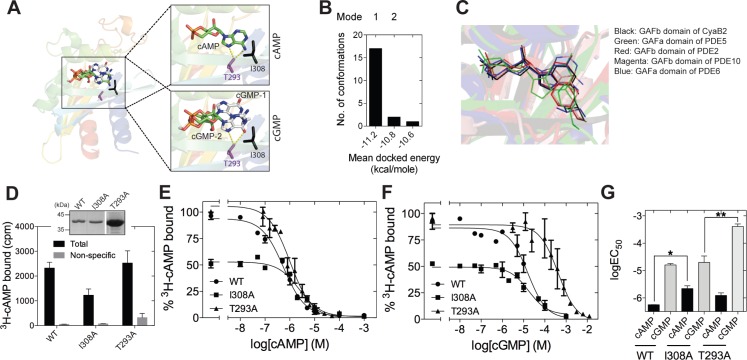
Ligand binding to the isolated GAFb domain of CyaB2.(A) Cartoon representation of the GAFb domain (PDB: 1YKD Martinez et al., 2005) with docked cAMP and cGMP conformers. Insets show zoomed in view of the ligand binding pocket of GAFb with docked cAMP and two different clusters of docked cGMP conformers indicated as cGMP-1 and cGMP-2. Side chains of T293 and I308 are also shown along with their interaction with the docked ligands. (B) Distribution of docked cGMP conformers obtained clustering with an RMSD of 0.5 Å. Mode 1 represents the cluster with maximum number of conformers and with lowest energy while mode 2 represents the cluster with cGMP docked in a way that mimics bound cAMP. Third cluster consisting of one conformer out of 20 was docked outside the ligand-binding pocket and therefore, has not been shown. (C) Conserved interaction between high affinity ligand, either cAMP or cGMP, with the residue equivalent to I308 in different cyclic nucleotide binding GAF domains (GAFb domain of CyaB2–cAMP [PDB: 1YKD]; GAFb domain of PDE2–cGMP [PDB: 1MCO]; GAFa domain of PDE5–cGMP [PDB: 2K31]; GAFb domain of PDE10–cAMP [PDB: 2E4S]; GAFa domain of PDE6–cGMP [PDB: 3DBA]. (D) Wild type (WT), I308A or T293A mutant GST-fusion proteins (∼1–5 µg) bound to glutathione beads were incubated with 3H-cAMP (∼1 nM) in the absence or presence of 10 µM unlabeled cAMP. Data shown is a representative of assays performed at least twice in duplicate, and values shown are mean ± S. E. M. for 1 µg protein. The inset shows a Coomassie stained gel picture of the purified proteins used in the assay. (E) and (F) Purified wild type, I308A or T293A mutant GST fusion proteins bound to beads were incubated with ∼1 nM 3H-cAMP and increasing concentration of unlabeled cAMP (E) or cGMP (F). Data shown is mean ± S. E. M of duplicate determinations and is representative of independent assays. (G) Log values of the IC50 obtained for the wild type, I308A or T293A mutant proteins with either cAMP or cGMP are plotted. Data shown is mean ± S. E. M. of IC50 values determined from multiple independent assays.